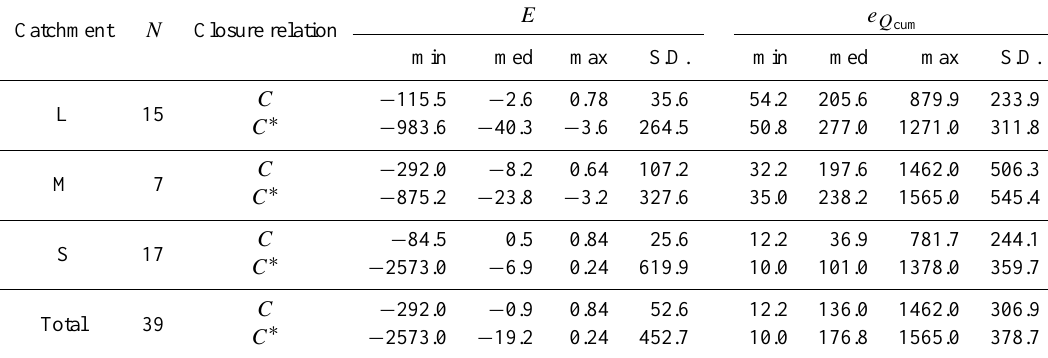
Table 8. Performance of C and C ∗ without calibration.